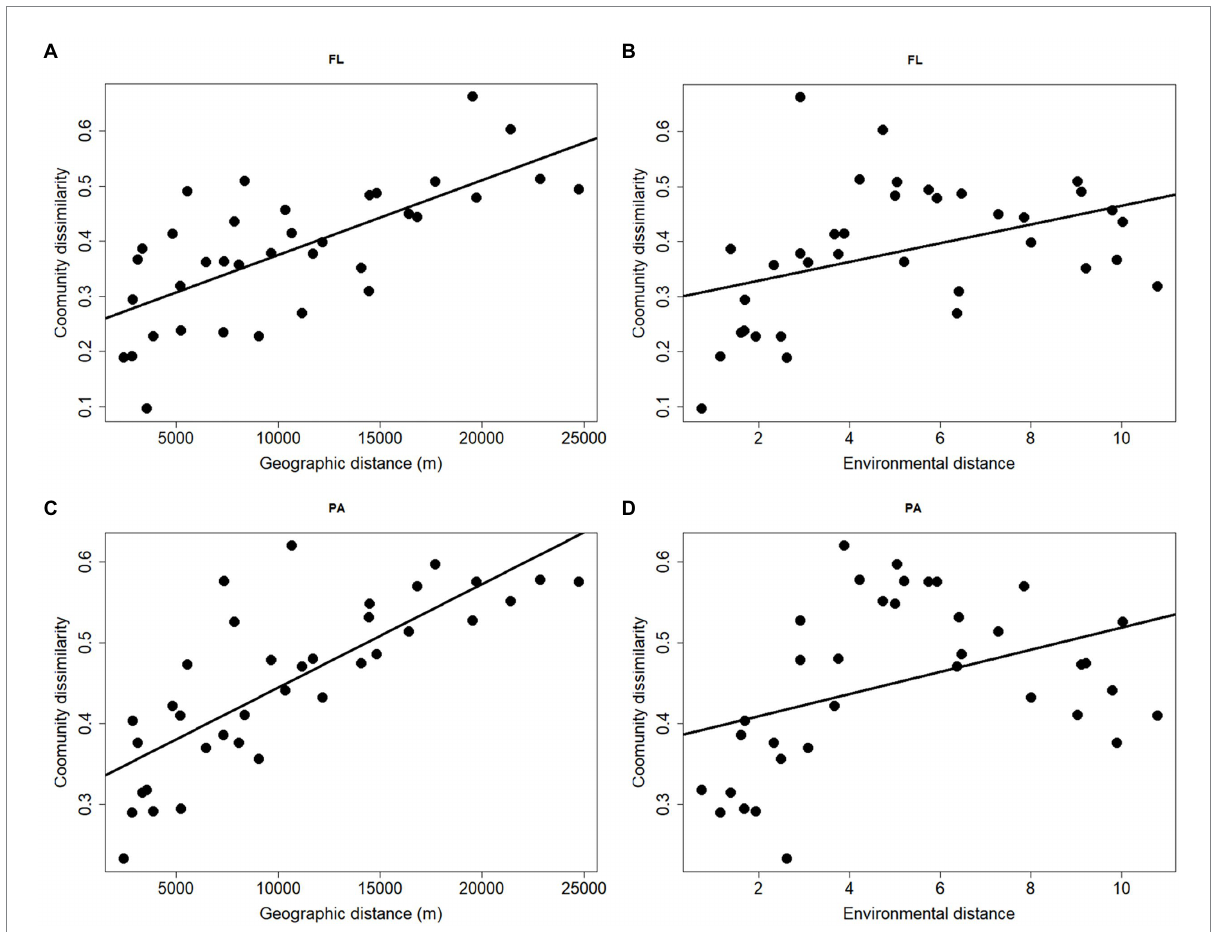
FIGURE 6 Relationship between geographic distance, environmental distance and Bray–curtis dissimilarity of FL (A,B) and PA (C,D) bacterial communities in Wujiangdu